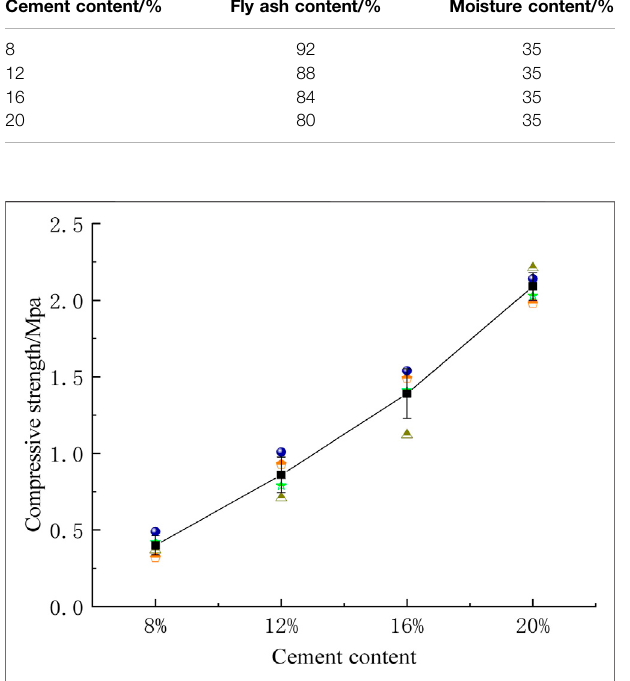
TABLE 3 | Cement fl y ash test block ratio table. Cement content/%